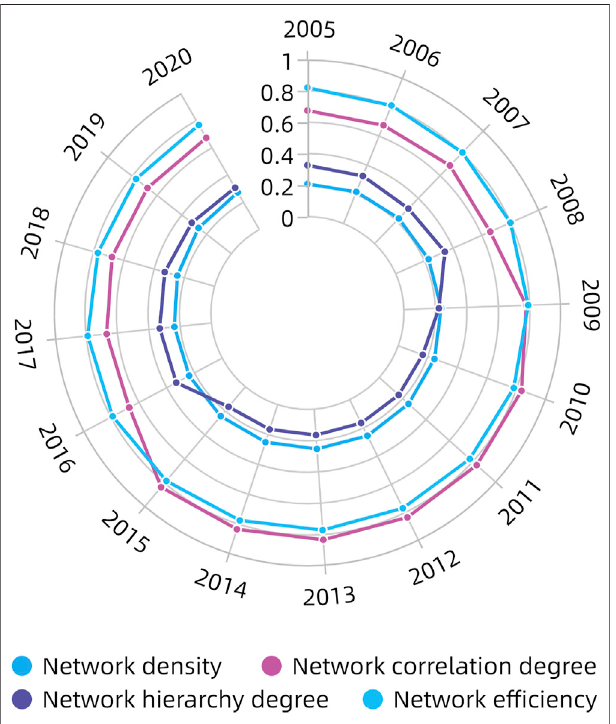
FIGURE 3 | Evolution trend of the overall network characteristics of the information entropy of the carbon emission structure in China from 2005 to 2020.